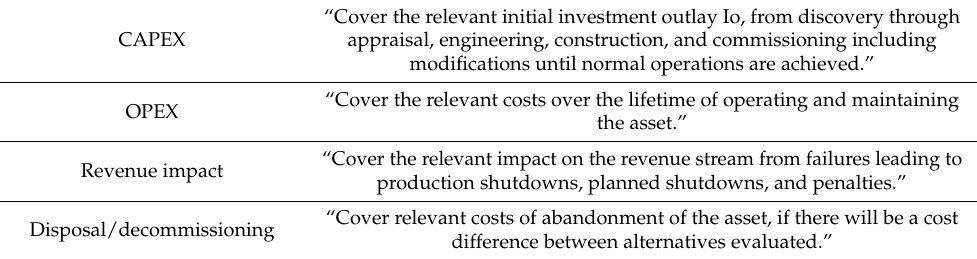
Table 1. Main cost elements within an economic evaluation method established by the standard ISO 15663-2:2001(E). Adapted from [36].